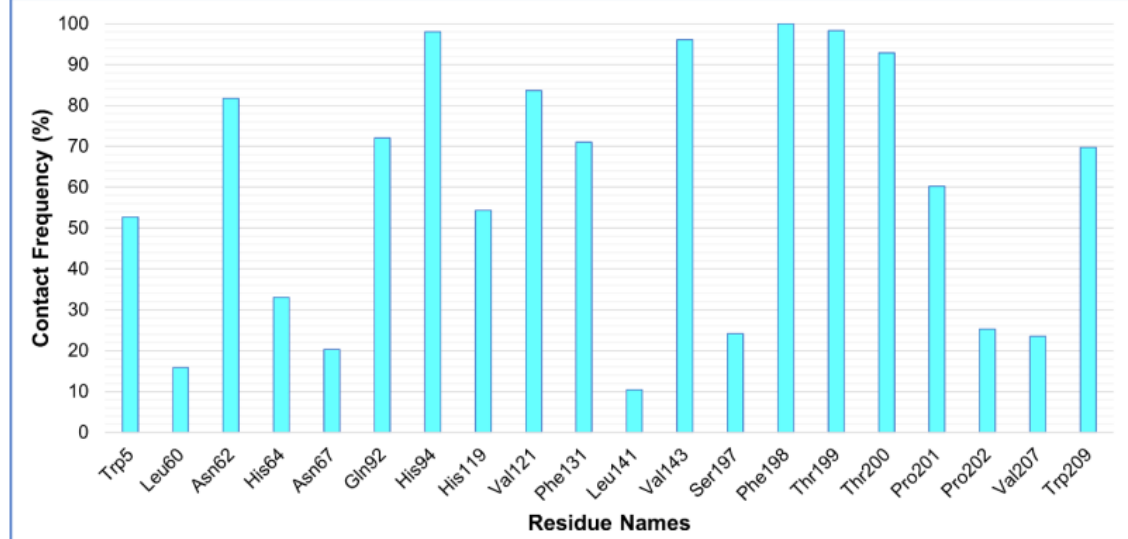
Figure 8. Hydrogen bond contact frequency of ZINC24751284 in a complex with carbonic anhydrase during the 100-ns molecular dynamics simulation. Table 2. Calculated binding free energies of the top three hits (kcal/mol).